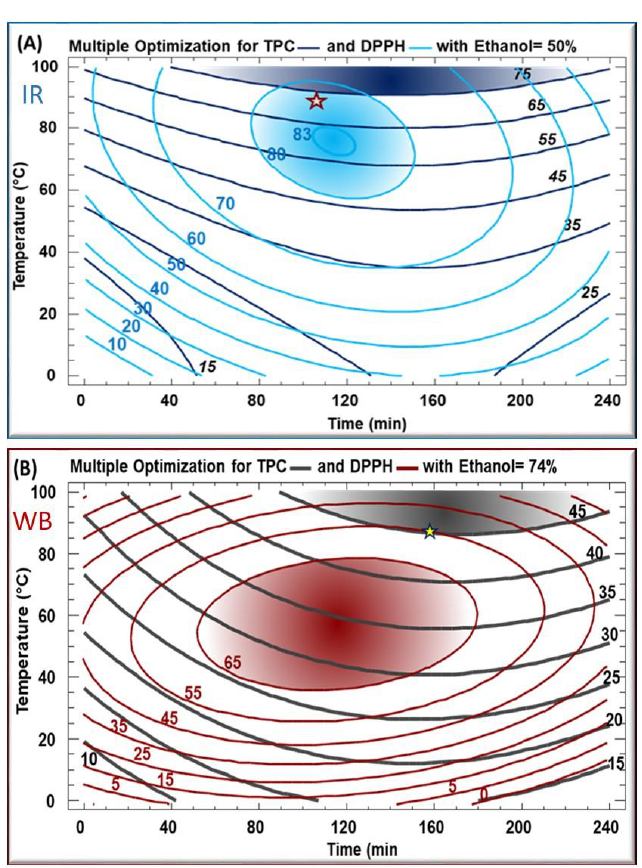
Figure 3. Contours plots generated from multiple response analysis for TPC and DPPH for Eryngium creticum IR ( A ) and WB ( B ) extracts. The star represents the multiple optimum conditions.